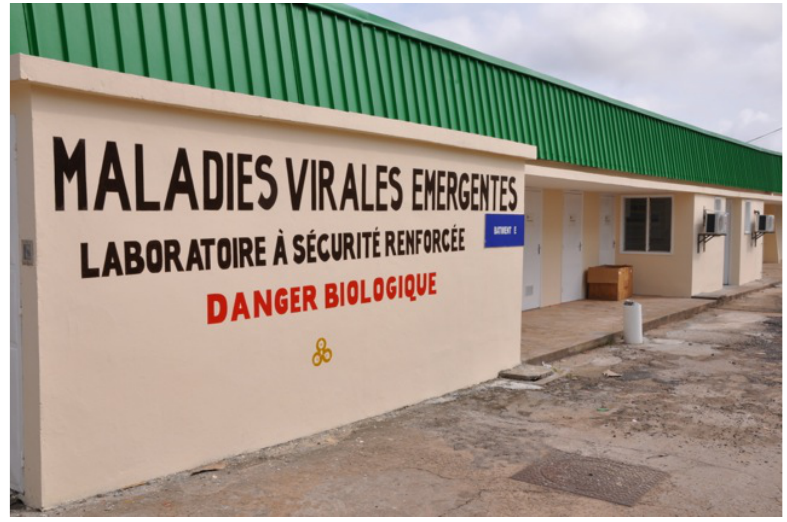
Figure 2. The International Centre for Medical Research of Franceville (CIRMF). Emerging Viral Diseases Unit P3 laboratory.